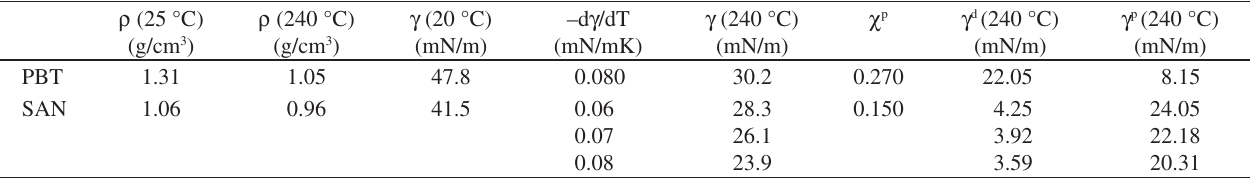
Table 4. Density ( ρ ), surface tension ( g ), (-d g /dT), surface tension components ( g d , g p ) and polarity ( c p ) for PBT and SAN, at different temperatures.